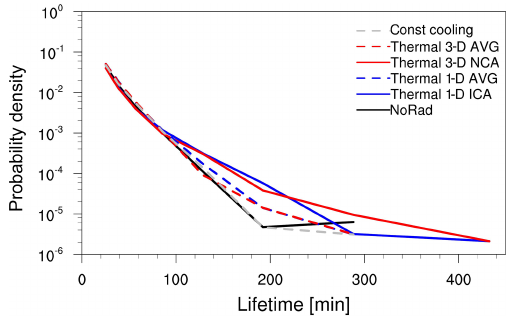
Figure 16. Probability density function of cloud lifetime: the life- time of each cloud detected by the tracking algorithm was calcu- lated within the first 20h of the